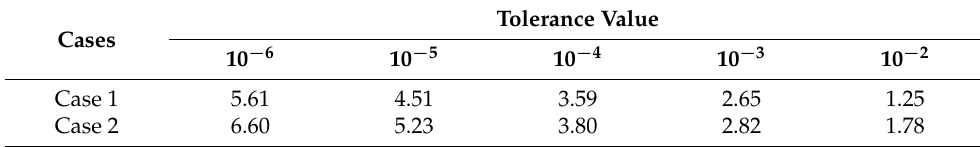
Table A4. Mean iteration number per time step for each tolerance condition in Case 1 and Case